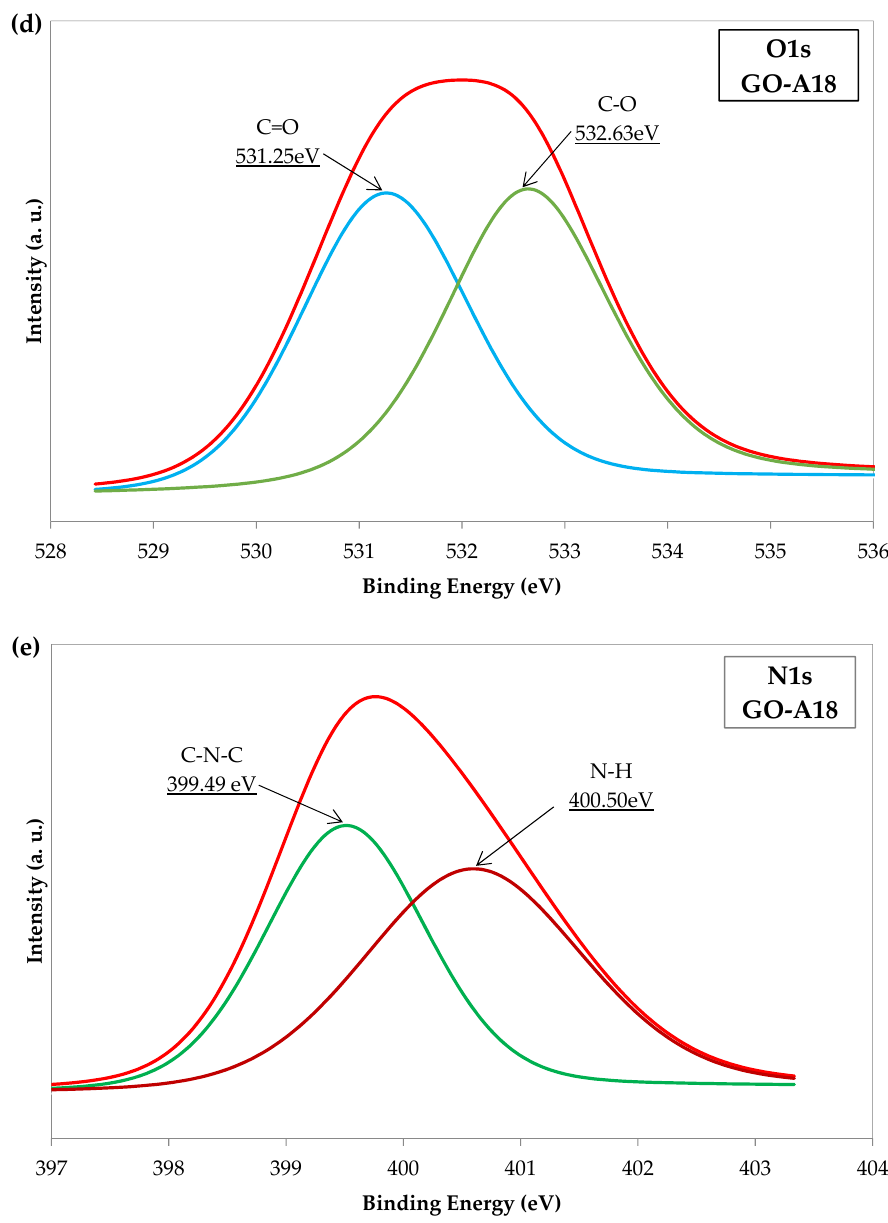
Figure 5. ( a ) XPS results of GO and functionalized-GO, and binding energy of ( b ) GO and ( c – e ) GO–A18.